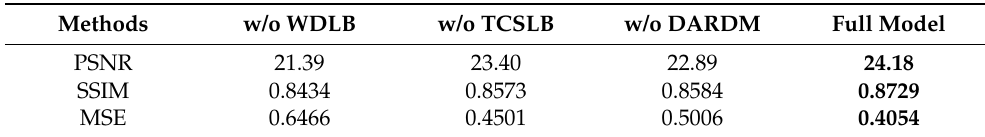
Figure 14. Ablation study of the performance of the model components. The number on each image represents its PSNR score. Table 4. Quantitative comparison results of the ablation study of the components of DBFNet in terms of PSNR (dB), SSIM, and MSE ( × 10 3 ) values. Bold values indicate the best results.